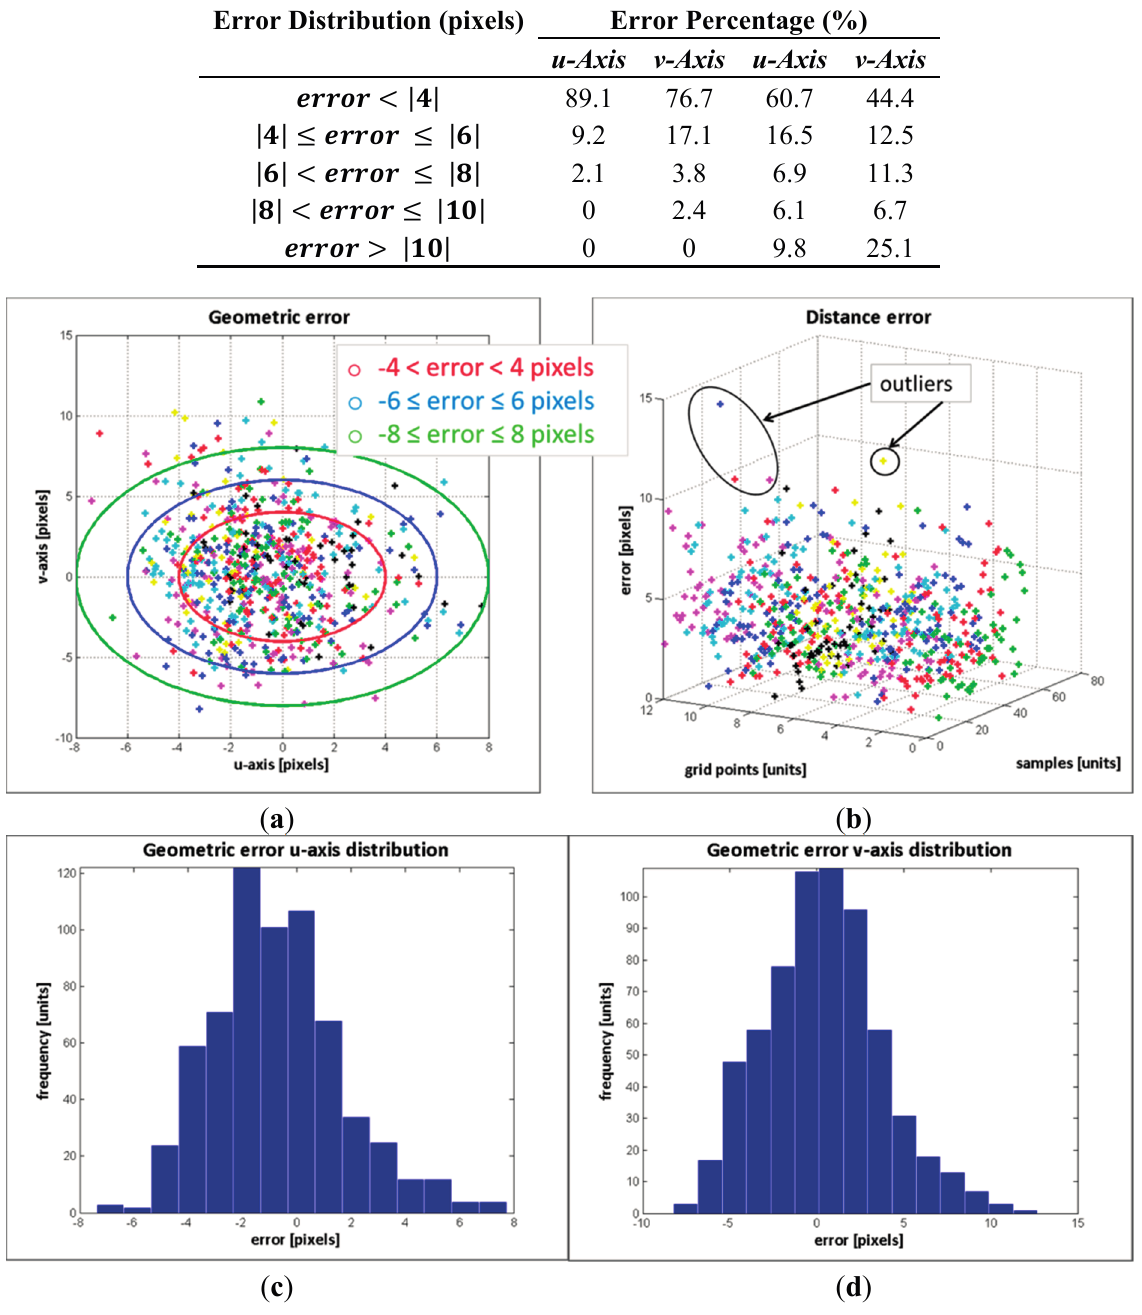
Figure 15. Error evaluation of the experimental tests corresponding to group #1. ( a ) geometric error; ( b ) distance error; ( c ) error distribution in u -axis; ( d ) error distribution in v